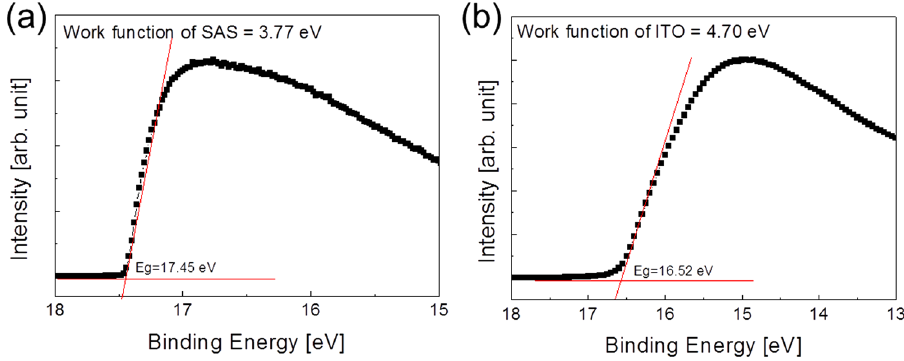
Figure 8. Work function of ( a ) SnO 2 /APC/SnO 2 multilayer and ( b ) ITO electrode obtained from UPS analysis.